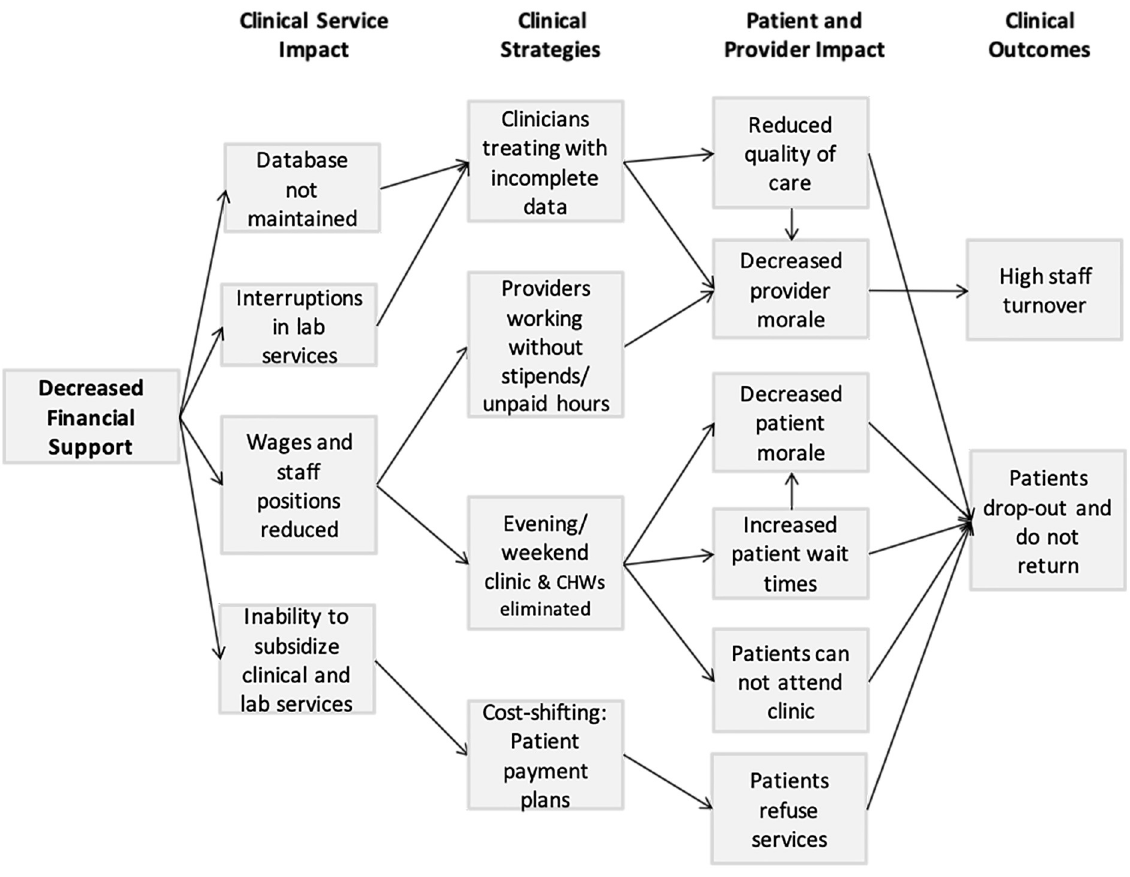
Fig 1. Thematic analysis of impact of PEPFAR policy changes on HIV clinical services and programmatic responses in APIN clinics.